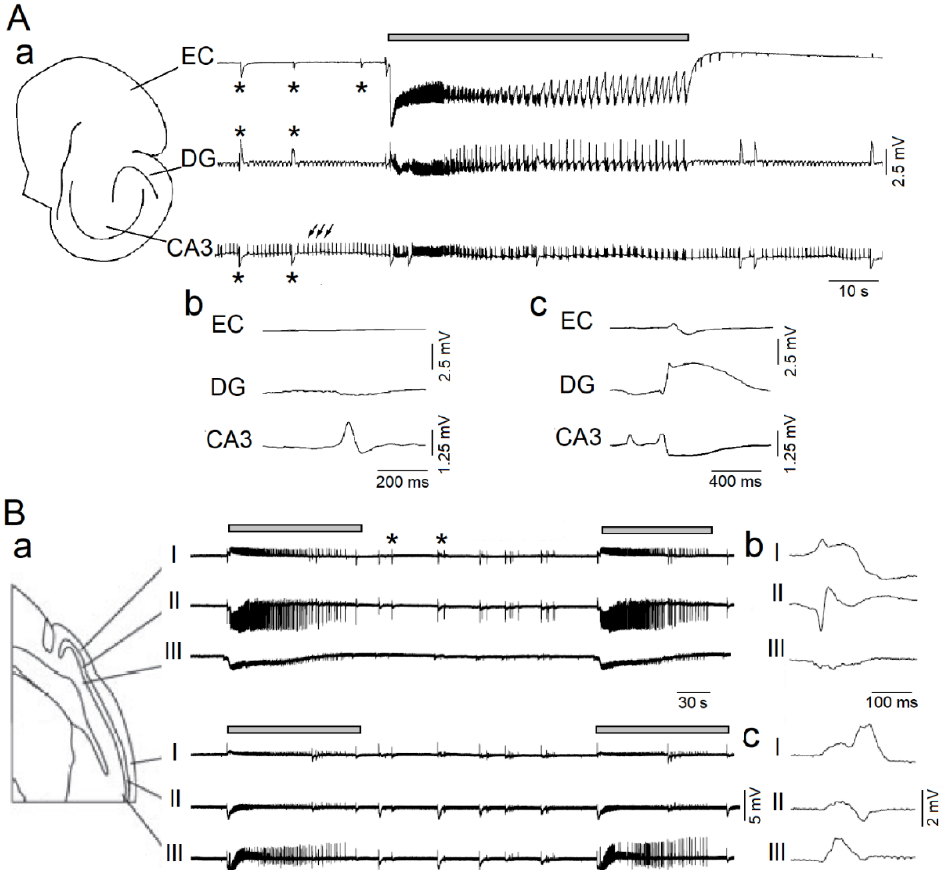
Figure 1. Epileptiform patterns induced by 4-aminopyridine (4AP) in rodent brain slices including the hippocampus-entorhinal cortex or the piriform cortex. ( A ): In panel ( a ), simultaneous field potential recordings obtained from the entorhinal cortex (EC), dentate gyrus (DG) and CA3 subfield of the hippocampus show the occurrence of three different types of epileptiform activity; the first (grey line)—which is recorded synchronously in all areas—consists of sustained discharge resembling a focal ictal discharge; the second type (asterisks) occurs in all areas and is characterized by slow interictal spikes; the third type (arrows) consists of continuous fast interictal-like events that are recorded in the CA3 subfield. Expanded traces of one fast and one slow interictal spike are shown in panels ( b ) and ( c ), respectively. ( B ): In panel ( a ), simultaneous field potential recordings obtained from the anterior and posterior portions of the piriform cortex in a sagittal slice; electrodes were positioned in layers I, II and III, as shown in the slice drawing. Note that both focal ictal discharges (grey lines) and interictal spikes (asterisks) occur spontaneously; two interictal spikes are expanded in panels ( b ) and ( c ). Panels shown in ( A ) and ( B ) are modified from the studies by Avoli et al. [36] and by Panuccio et al. [37], respectively.